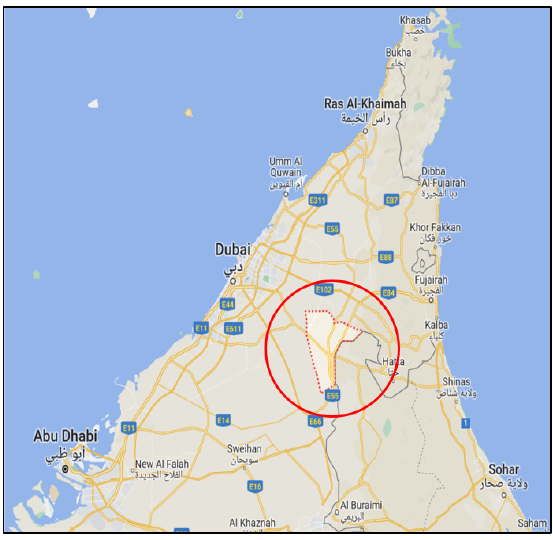
Figure 9. Location of Al ‐ Madam town, UAE. Google maps. Accessed on 15 October 2022.